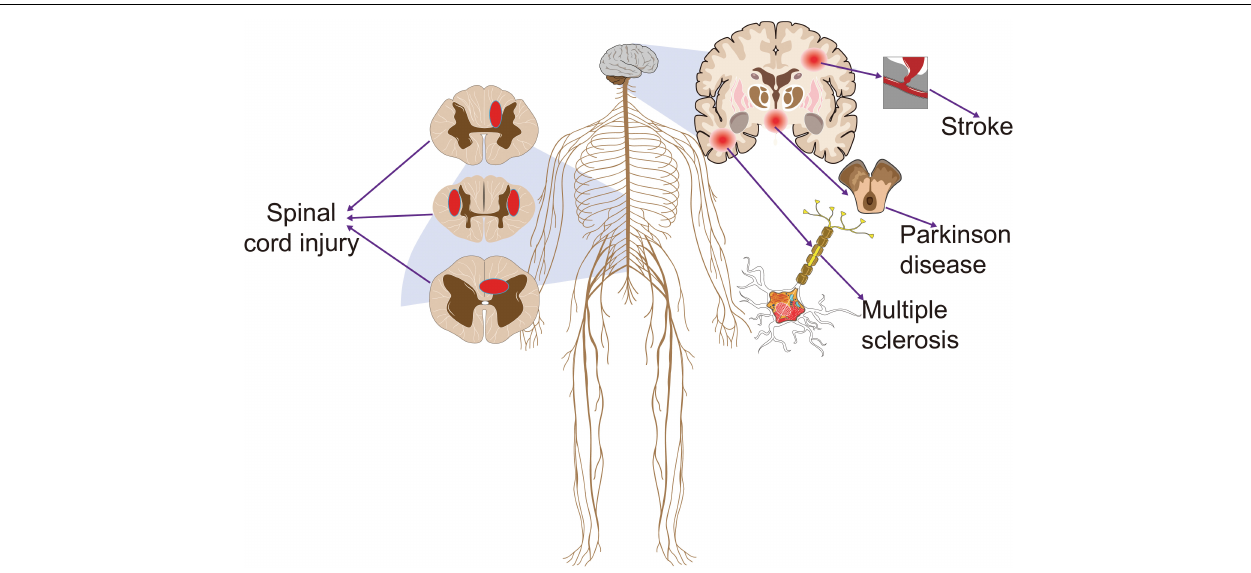
FIGURE 1 | The common diseases that cause central neuropathic pain. Stroke, Parkinson’s disease, multiple sclerosis, and spinal cord injury often lead to central neuropathic pain that persists throughout the recovery cycle. This pain clearly has a negative effect on the prognosis of